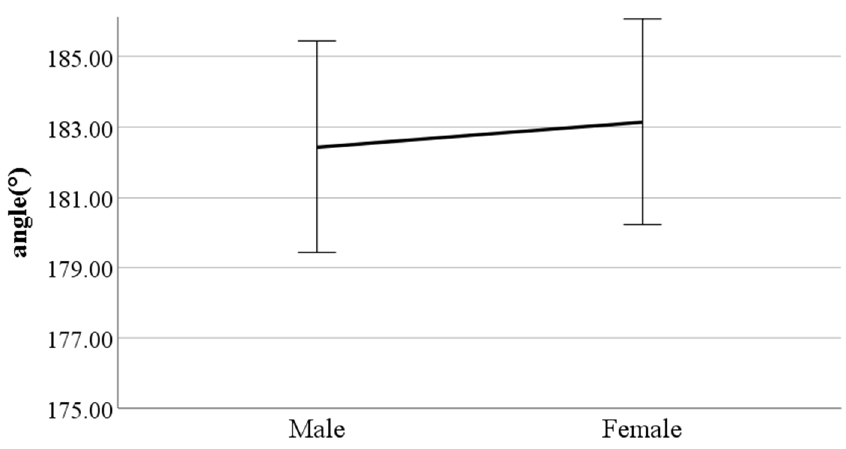
Figure 20. Gender difference in head movements in the frontal plane at the double support phase (left foot forward) (F value: 3.37, DF: 289, p -value: 0.02).